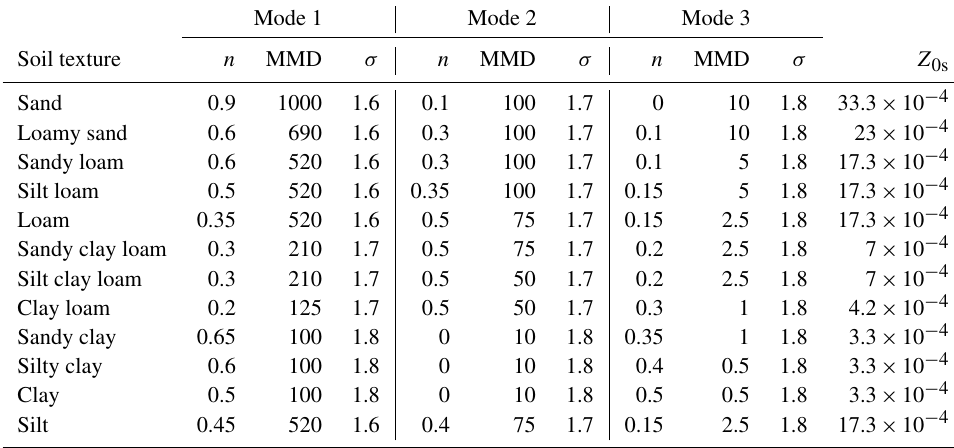
Table 1. Input soil aggregate size distribution parameters dependent on soil texture classification following USDA.